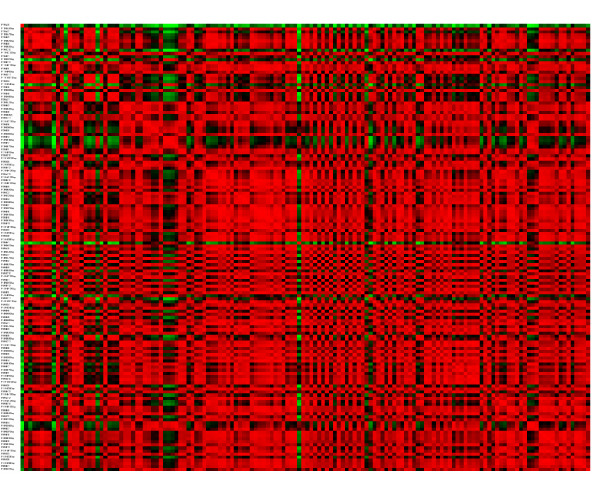
Heat map of correlation matrix of the 144 spectra from quality control samples. The Pearson product-moment correlation coefficient (R) is a measure of the degree of linear relationship between two spectra. A higher correlation indicates a more similar protein expression pattern between two samples for the two spectra. Each row and column in the heat map of the correlation matrix represents a spectrum. Each point is a Pearson correlation coefficient, R, between the spectrum in the column and the spectrum in the row. The correlation coefficients were colored by the values of R. The higher the value of R, the brighter red is the data point. The lower the value of R, the brighter green is the data point. All 144 data points in one row (same for column) represent the correlation of one spectrum to all other spectra. Therefore, the green line indicates the spectrum does not correlate well to other spectra. The correlation matrix was calculated using software JMP 5.1  and the heat map was created using the software DMVS 2.0 (Shenzhen Chipscreen Biosciences, Ltd, Shenzhen, P. R. China, )